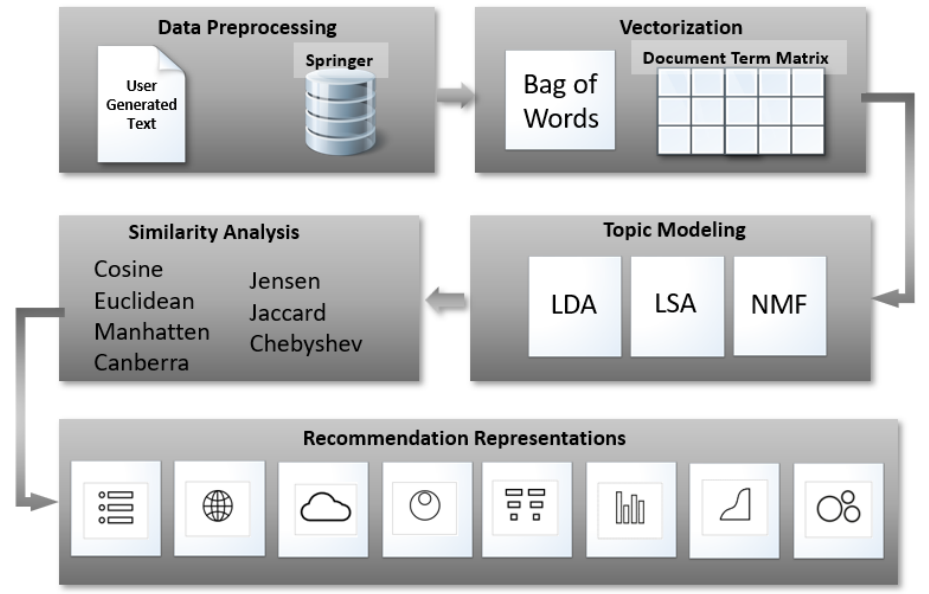
Figure 1. The general approach to identify similar publications by analyzing text in real time consists of commonly utilized natural language processing (NLP) approaches of preprocessing, vectorization of terms, topic modeling, calculating the similarity of the written text’s topic with that of available publications, and presenting the